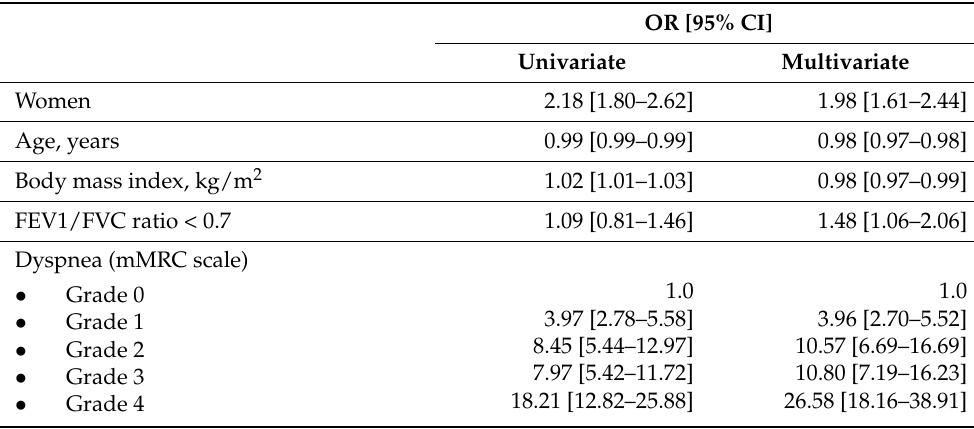
Table 2. Univariate and multivariate analyses ( n =